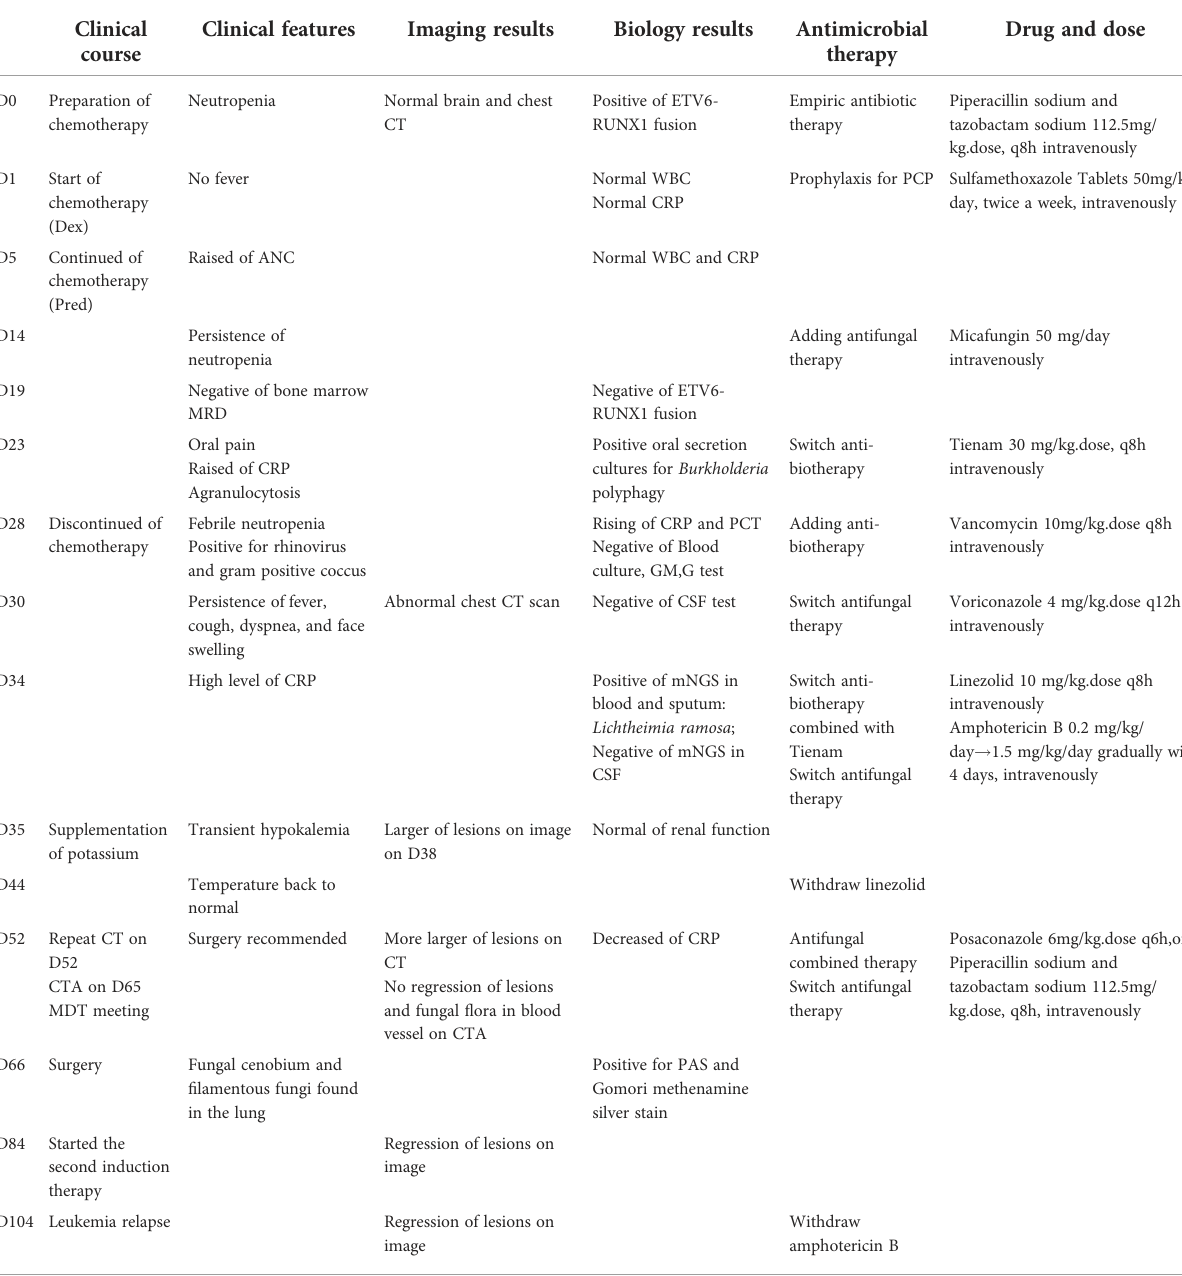
TABLE 1 Timeline of